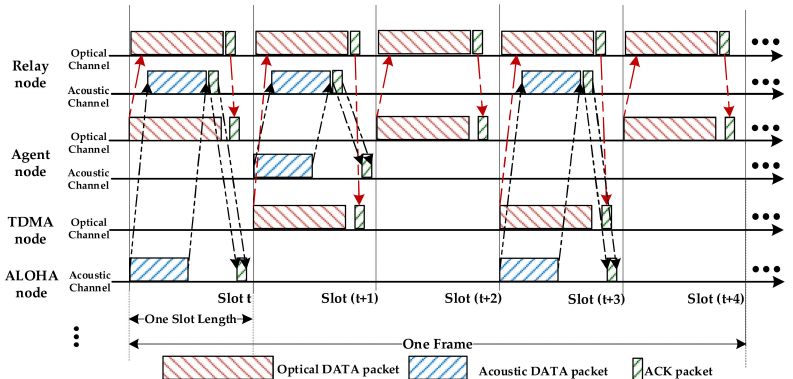
Figure 3. Slotted operations of two non-agent nodes and one agent node towards one relay node: One of the non-gent nodes uses an optical channel to send data packets, another occupies an acoustic channel for packet transmissions. They do not interfere with each other. The agent can utilize the unused time slots for